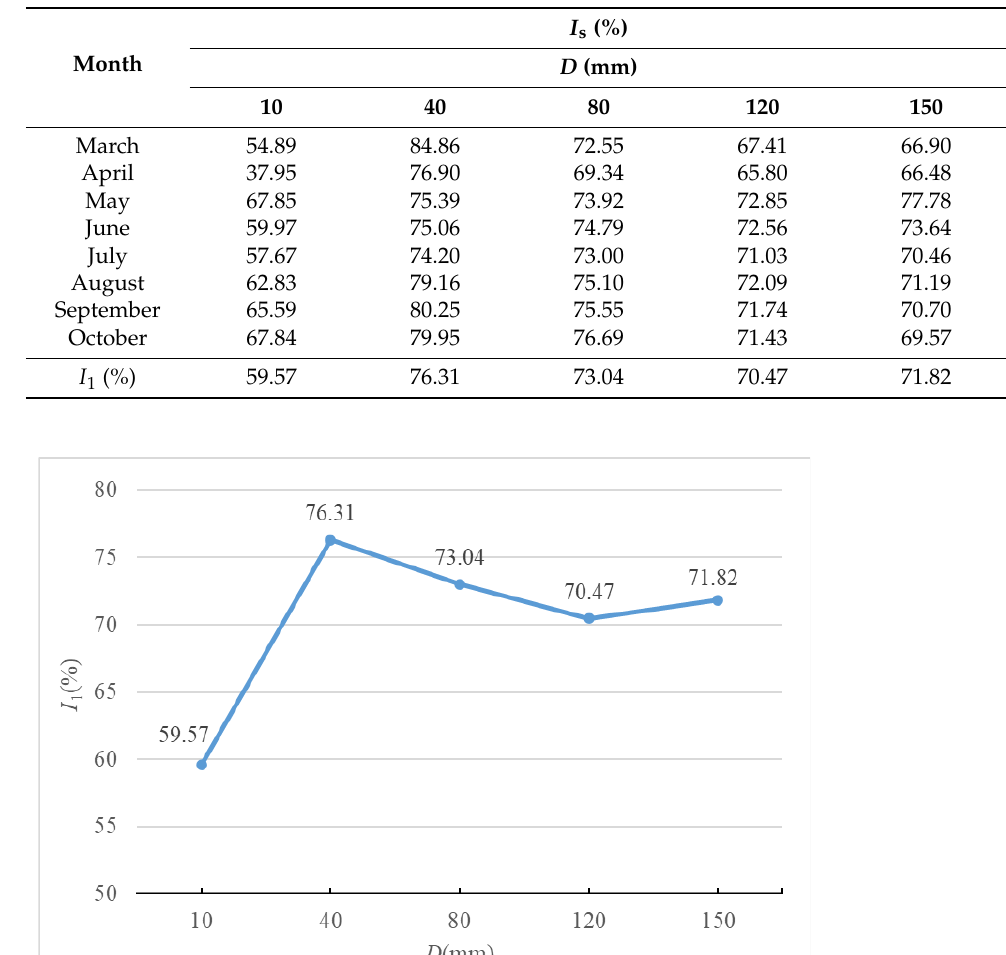
Table 5. ESE of evaporator test by month.